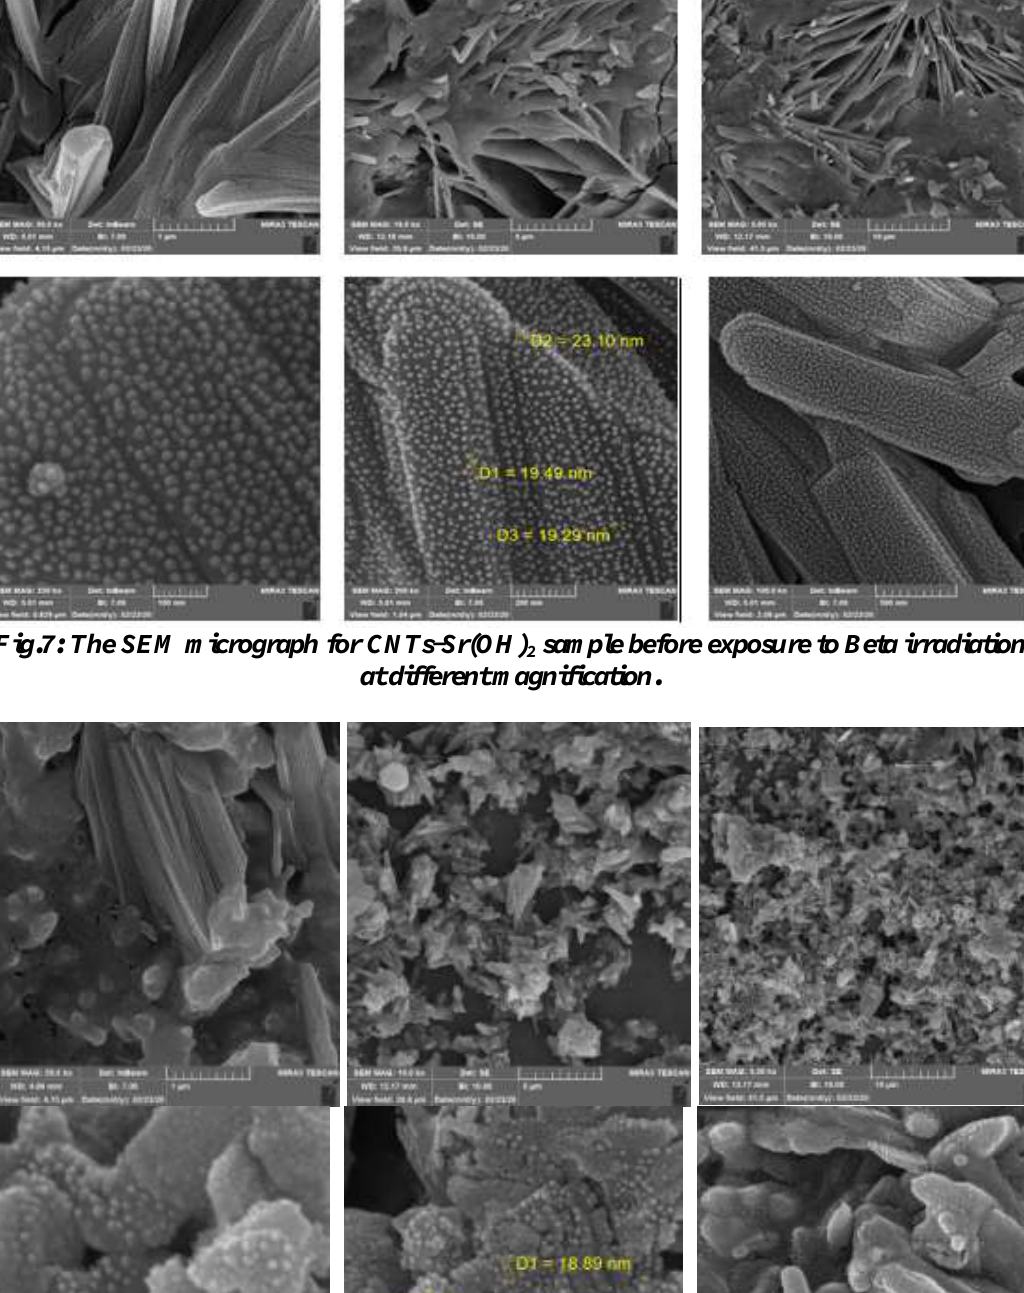
sample after exposure to 2 Beta